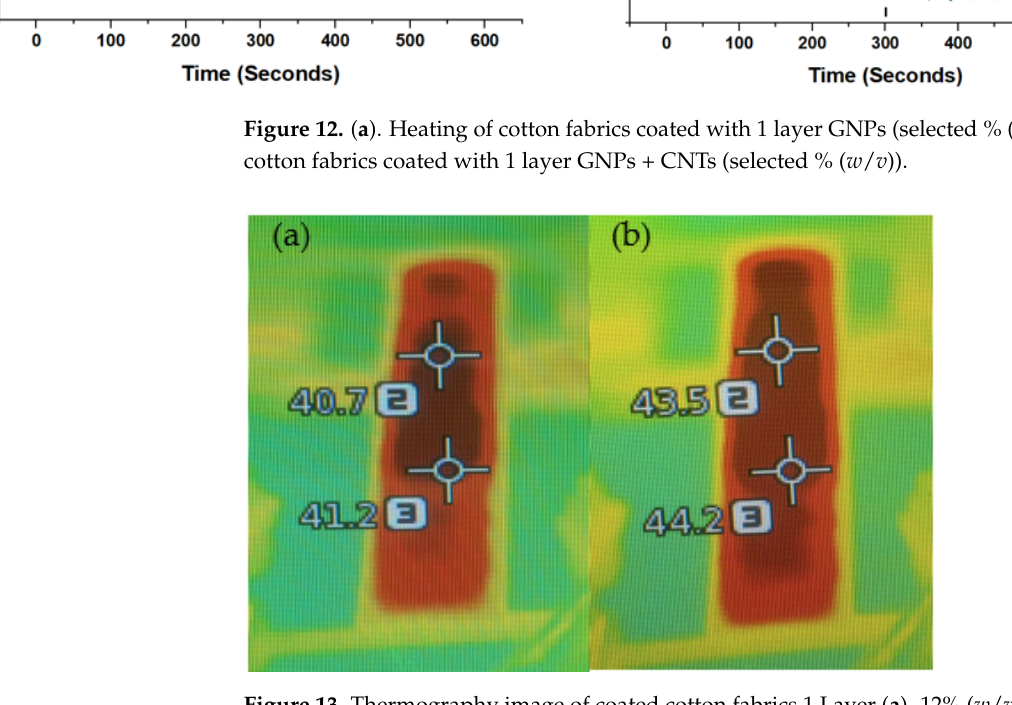
Figure 13. Thermography image of coated cotton fabrics 1 Layer ( a ). 12% ( w / v ) GNPs; ( b ). 5% ( w / v ) GNPs + CNTs.